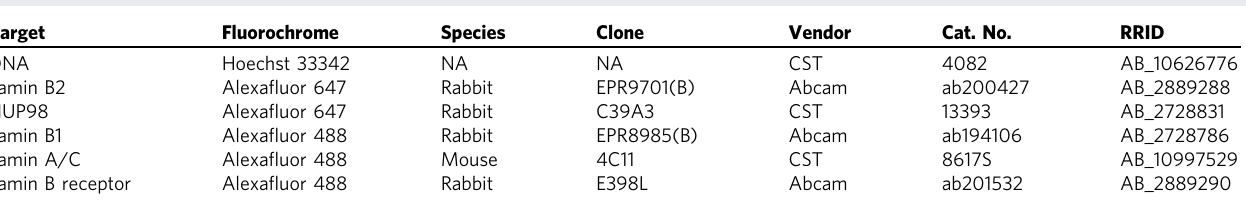
Table 1 Antibodies used for immuno fl uorescence